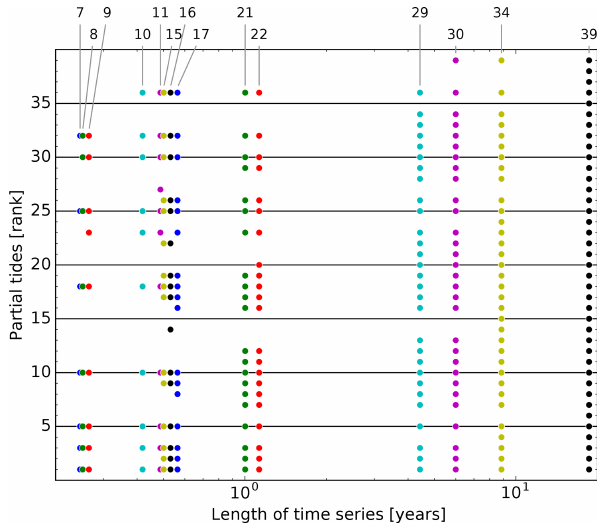
Figure 6. The partial tides (identified by their rank R from Ta- ble 4) that can be resolved as a function of the (minimum) length of the time series. If two partial tides cannot be resolved against each other, the one with the lower rank is dropped. Note the logarithmic time axis from 0.2 to 20 years. The numbers at the top are the counts of partial